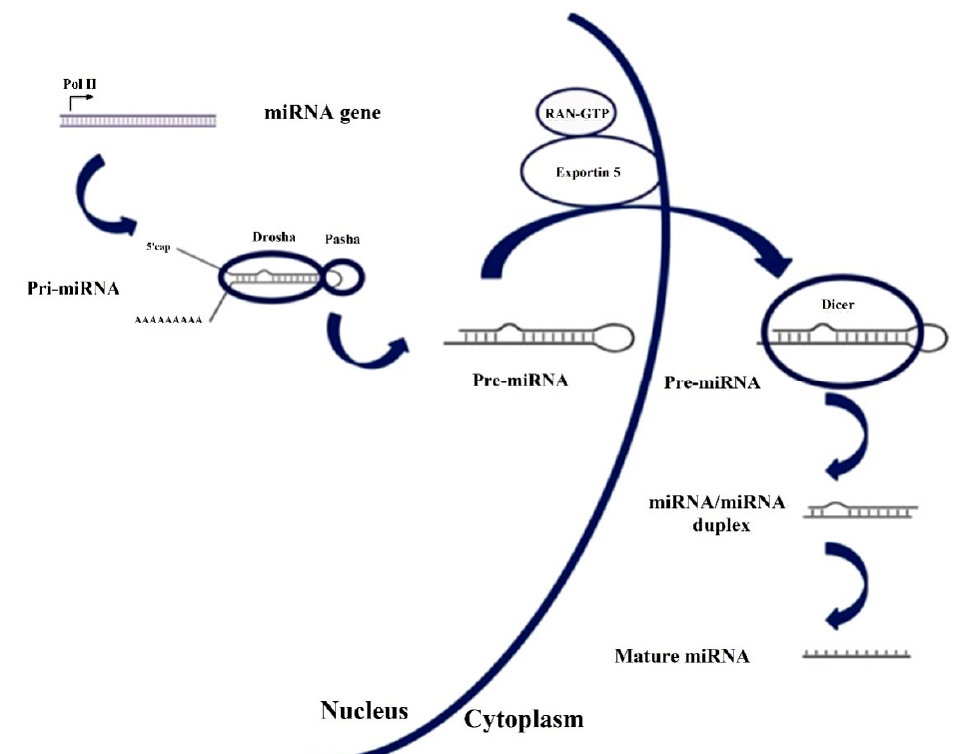
Figure 1. Biosynthesis pathway for miRNA. Reproduced under the terms of the Creative Commons Attribution-Non Commercial 3.0 Unported License (https://creativecommons.org/licenses/by-nc/3.0/)